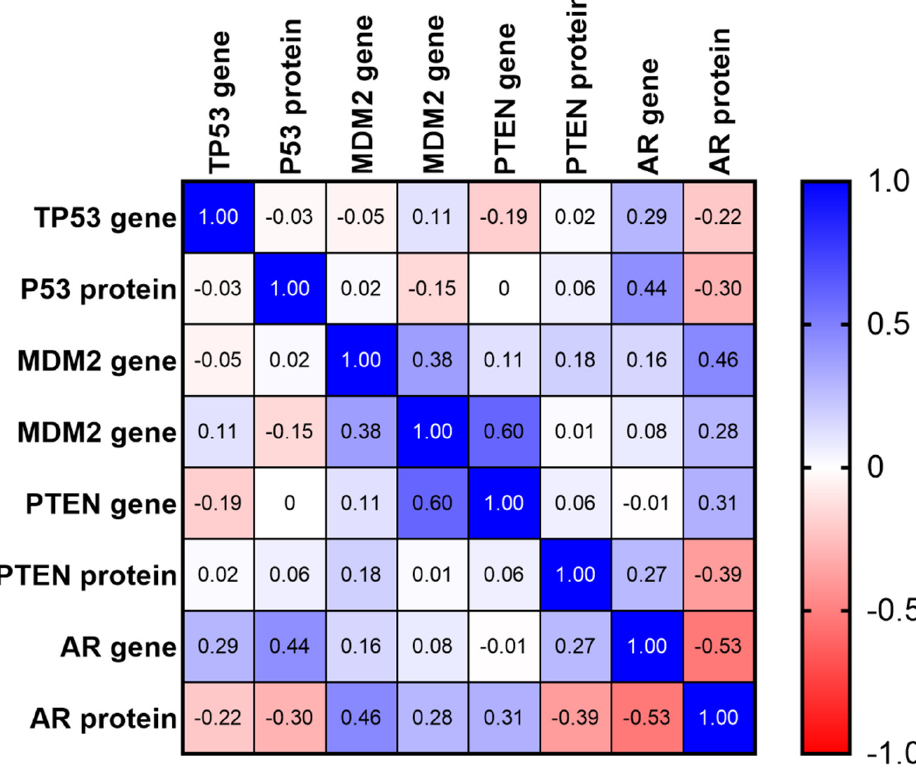
Figure 6. Matrix of multiple correlation among PTEN, TP53, MDM2 and AR gene and protein expression. The red color represents negative correlation and the blue color represents a positive correlation. The color intensity is associated with a strongest correlation. The blue color represents a positive correlation and the red color represents a negative correlation.